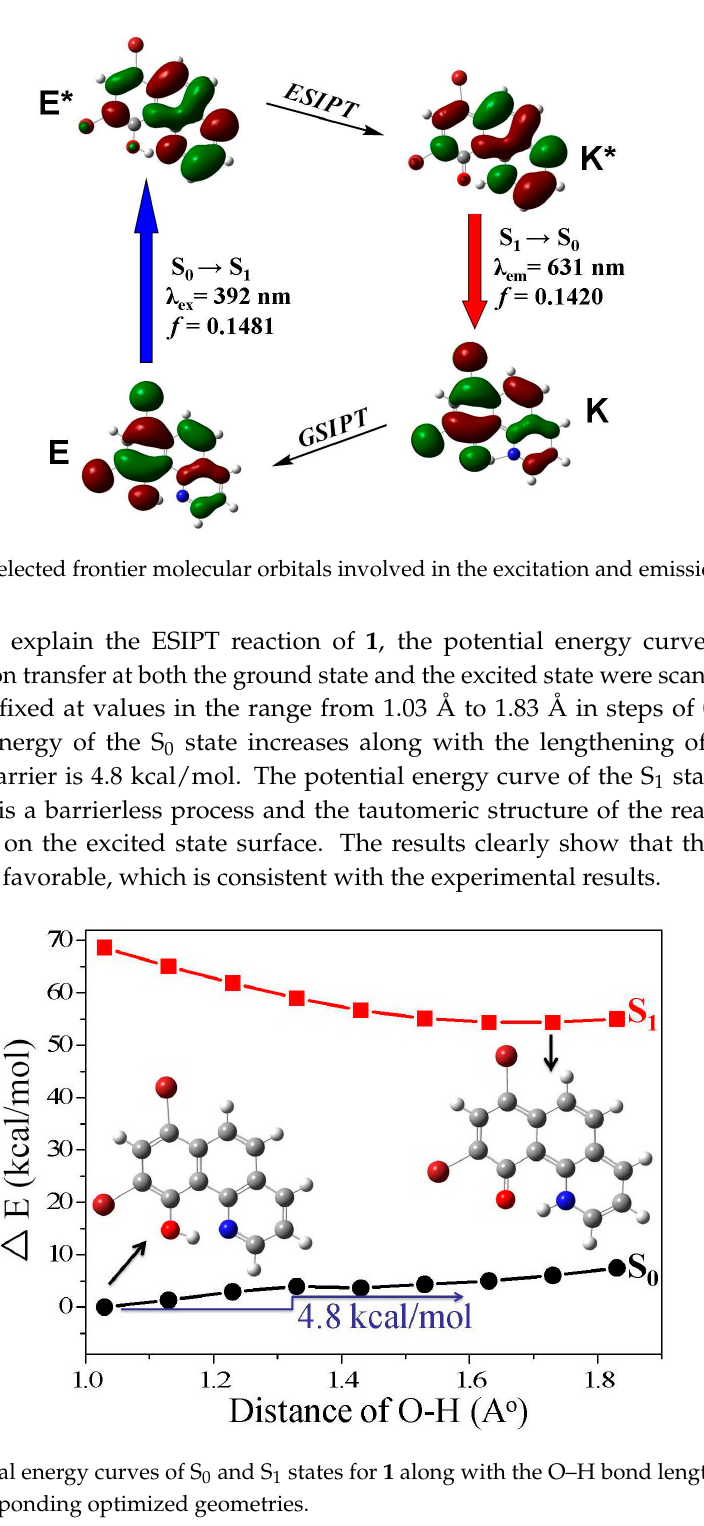
Figure 6. Potential energy curves of S 0 and S 1 states for 1 along with the O–H bond length. The insert shows the corresponding optimized geometries.